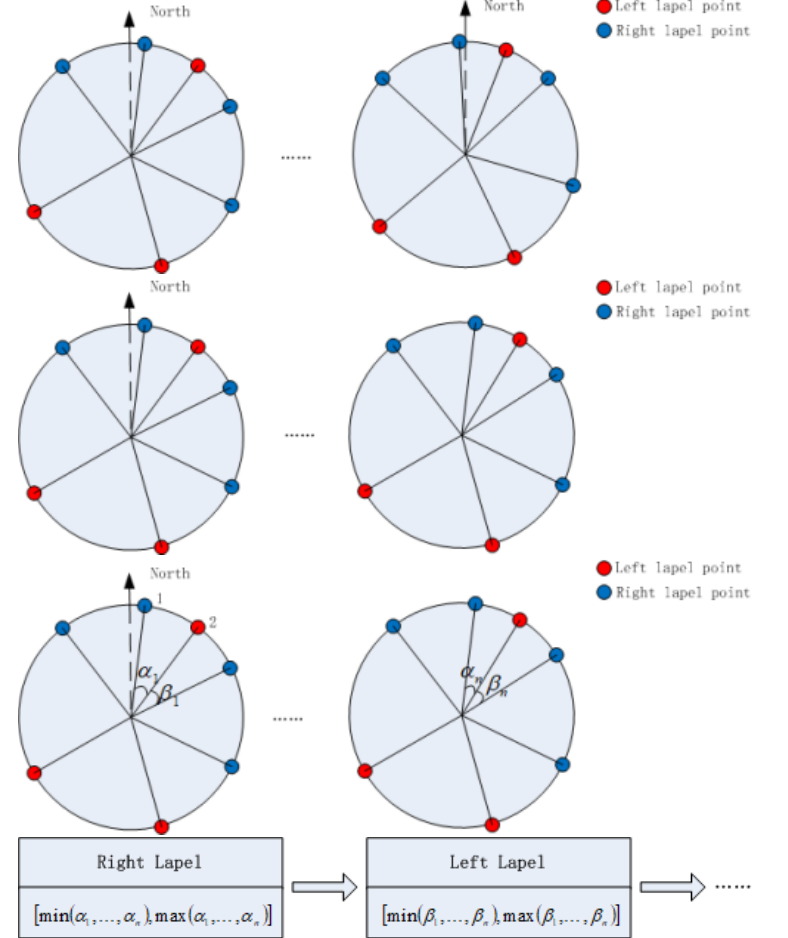
Figure 20. The feature extraction map of skyline type lapels: ( First row ) n skylines in the same category considered by the clustering method to have the same geometry; ( Second row ) based on the lapel point sequence of the first skyline in the same category, adjust the sequence of the remaining skyline lapel points to correct the changes caused by the position of observation points; ( Third row ) statistics of the type and angle of each lapel point; and ( Fourth row ) skyline lapel point index, which records the type and angle range of each lapel point category.